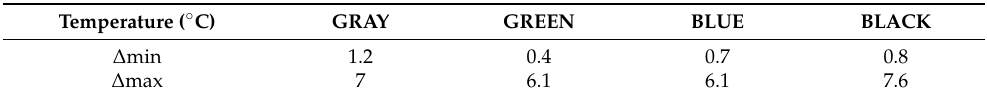
Table 1. Temperature difference between the unshaded and the shaded treatments (gray, green, blue, or black net).